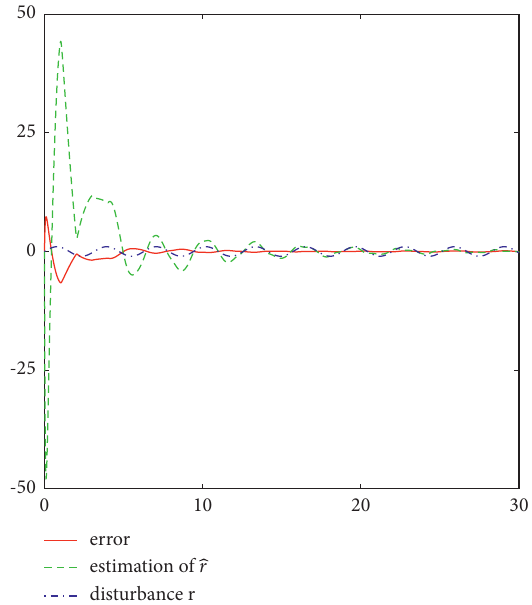
Figure 4: The displacement of r , 􏽢 r , and 􏽥 r